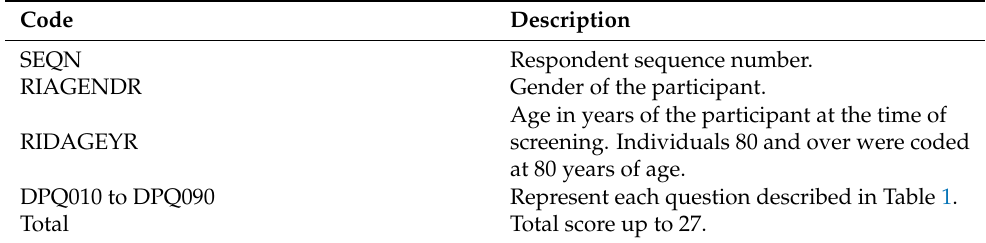
Table 3. Code and description of the melted